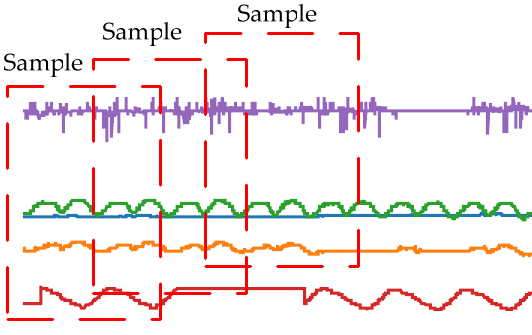
Figure 4. Schematic of the sliding